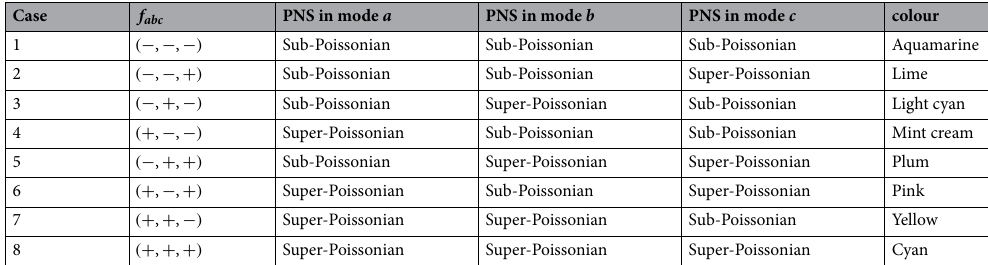
Table 1. Different predictions of the super- and sub-Poissonian particle (i.e., photon, phonon or hybrid photon–phonon)-number statistics (PNS) corresponding, respectively, to PIT and PB, for the photon mode a , phonon mode b , and hybrid photon–phonon mode c ,